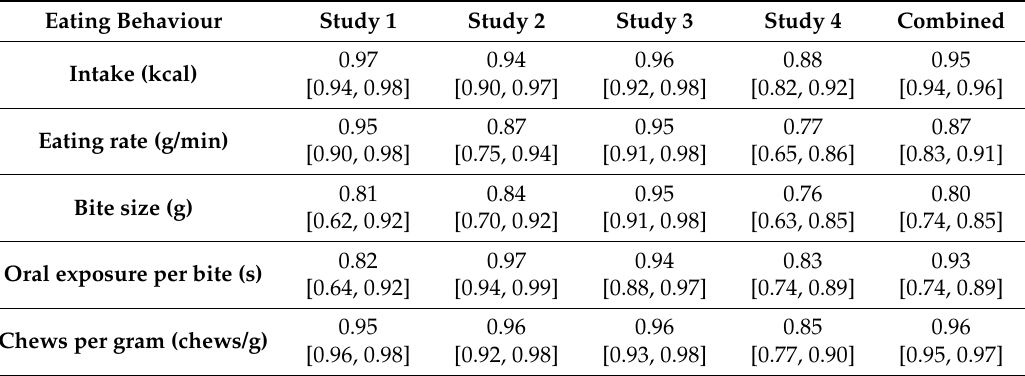
Table 2. Intra-class correlation coefficients (ICC) with 95% confidence intervals for eating behaviours across the four sessions within each study. Eating Behaviour Study 1 Study 2 Study 3 Study